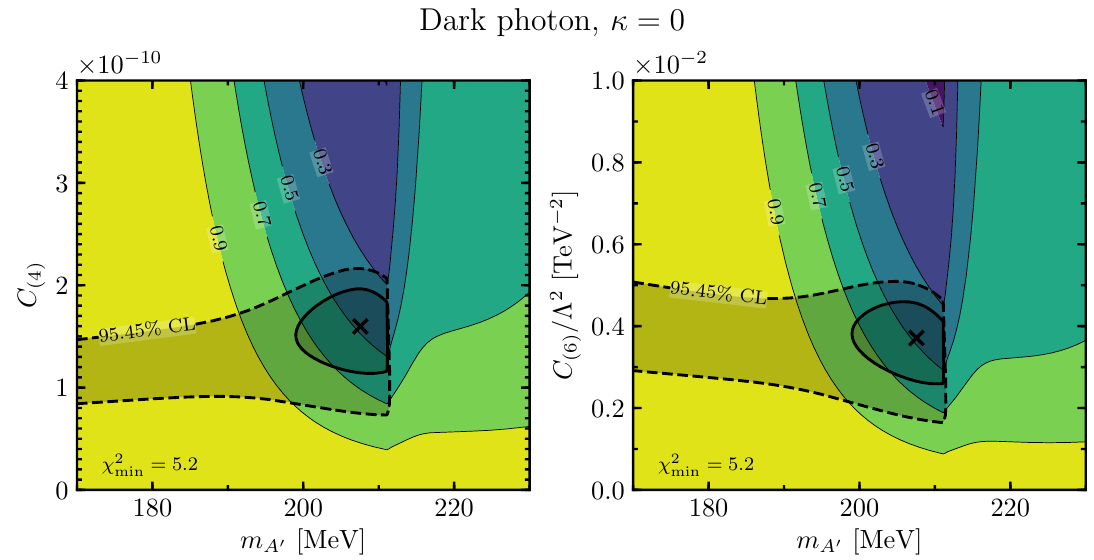
Figure 5 . Contours of the values of R K for a dark photon with (cid:20) = 0 as a function of the Wilson coe(cid:14)cients C (left) and C (right), and the dark-photon mass, m A 0 . Superimposed is the best-(cid:12)t (4) (6) region from the measurement of R K (cid:3) , B ! K (cid:3) A 0 ( ! (cid:22) + (cid:22) (cid:0) ) and B ! K (cid:3) e + e (cid:0) . We do not show the corresponding case for Q because in the best-(cid:12)t region the e(cid:11)ects in R K are unobservably small. (5)